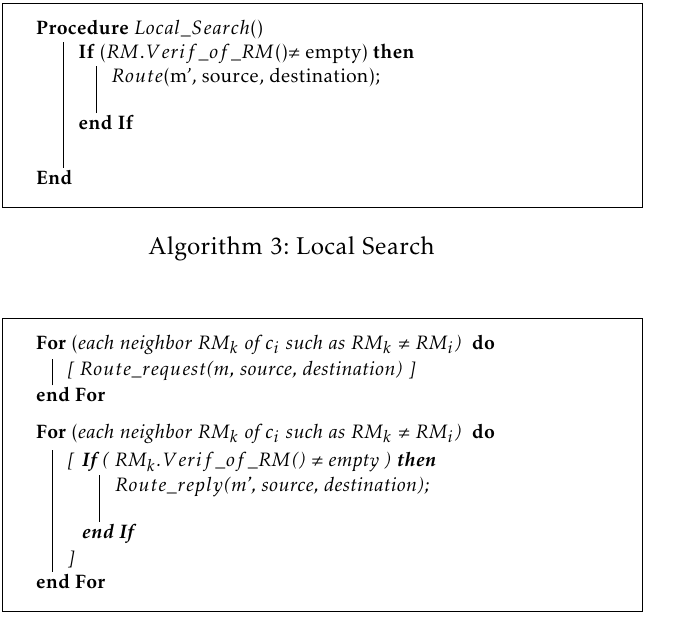
Algorithm 4: Broadcasting message to nodes RMs